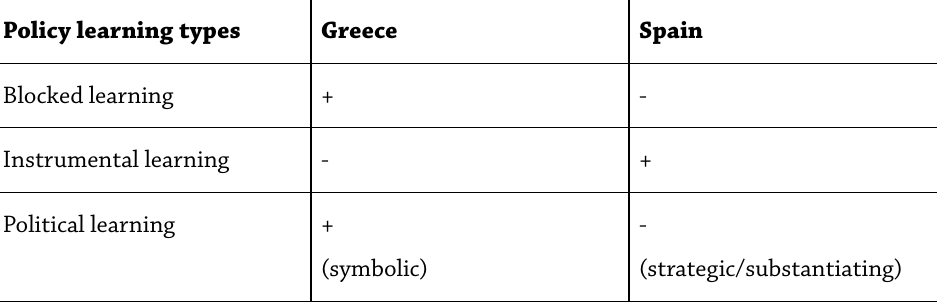
Table 3: Policy learning variations between Greece and Spain Policy learning